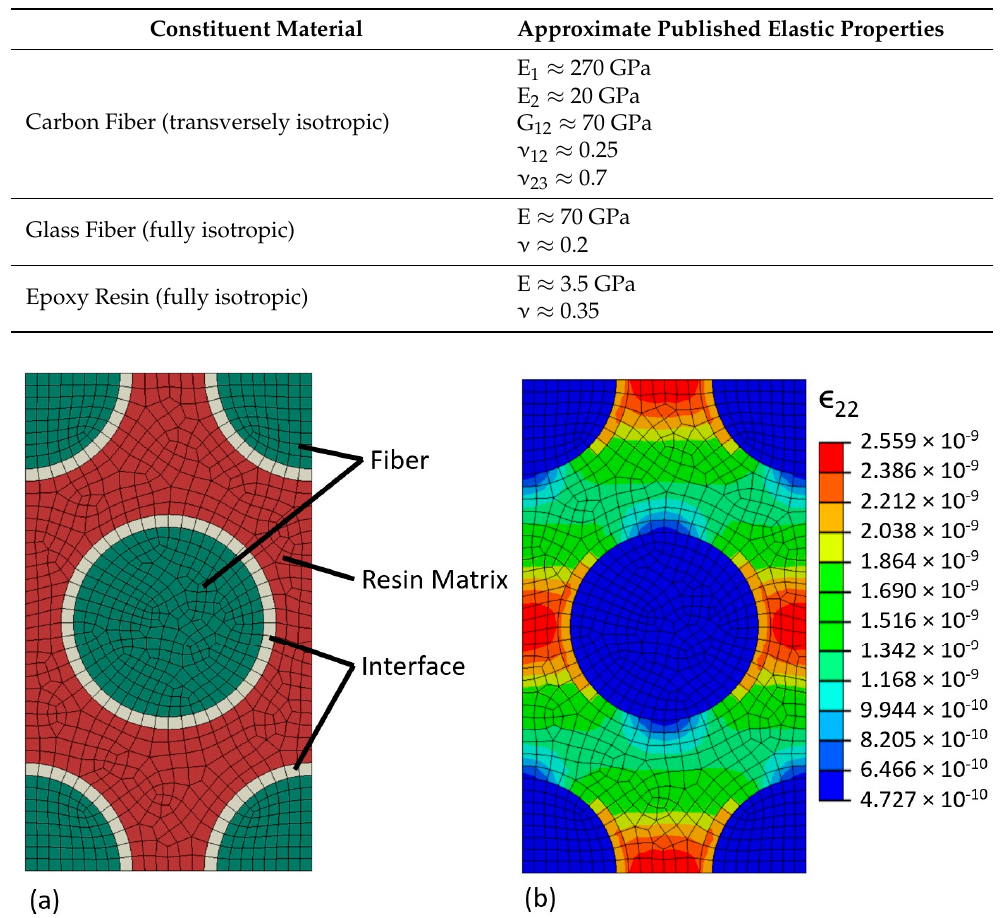
Figure 4. ( a ) Cross-sectional depiction of finite element RVE model of fiber-reinforced polymer lamina and ( b ) periodic strain response under transverse loading.